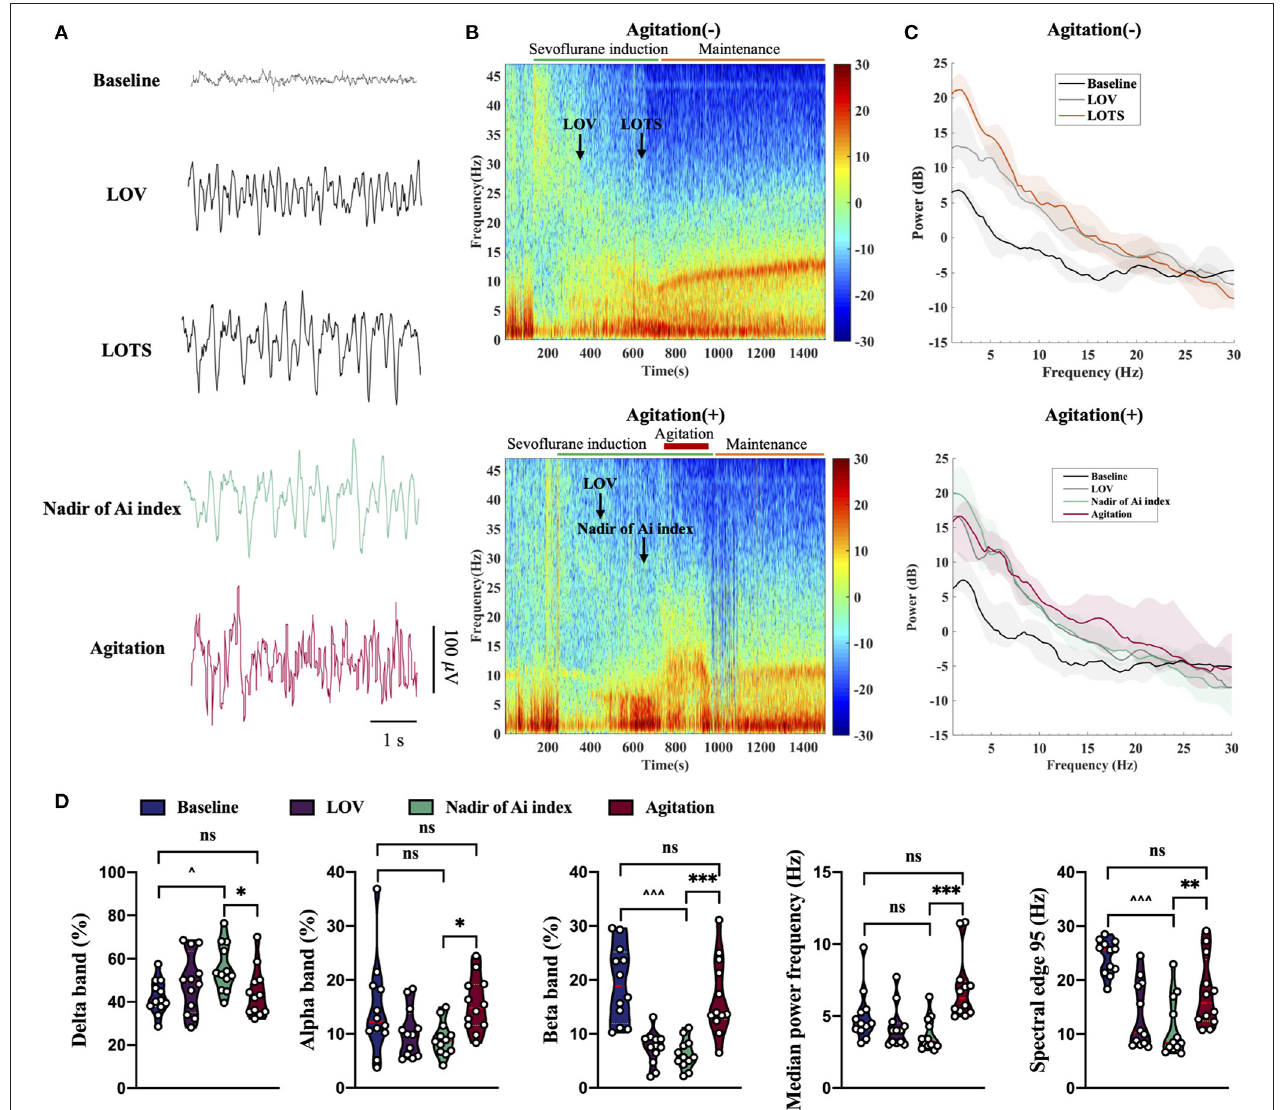
FIGURE 4 | Unprocessed EEG waveform, spectrogram, spectrum and EEG analysis from agitation ( + ) group ( n = 15) and agitation (-) group ( n = 15). (A) Sample of 5s EEG traces recorded during sevoflurane-induced different states. Agitation displayed a significant transition of the EEG oscillations to high frequencies with spikes. (B) Spectrogram shown an increase in the fast waves (alpha and beta) and a decrease in the slow rhythms (delta) during agitation. The LOV, LOTS, Nadir of Ai index, and agitation period are shown. (C) Spectral bands of delta (1–4Hz), theta (4–8Hz), alpha (8–13Hz), and beta (13–30Hz) were analyzed from two groups. The power spectra across the 1–30Hz frequency band were presented (solid line, median; shaded area, 25th − 75th percentile). (D) Changes in delta band (%), alpha band (%), beta band (%), MPF, and SEF95 during agitation. Center (red) line, median; green line, upper and lower quartiles. * p < 0.05, ** p < 0.01, *** p < 0.001; ∧ p < 0.05, ∧∧∧ p < 0.001; ns, not significant; Non-parametric repeated measures analysis of variance (Friedman’s test) using Bonferroni post hoc tests (D) . EEG, electroencephalogram; EMG, electromyography; Ai index, the depth of anesthesia index; MAP, mean arterial pressure; HR, heart rate; LOV, loss of verbal; LOTS, loss of response to trapezius squeeze; MPF, median power frequency; SEF95, spectral edge